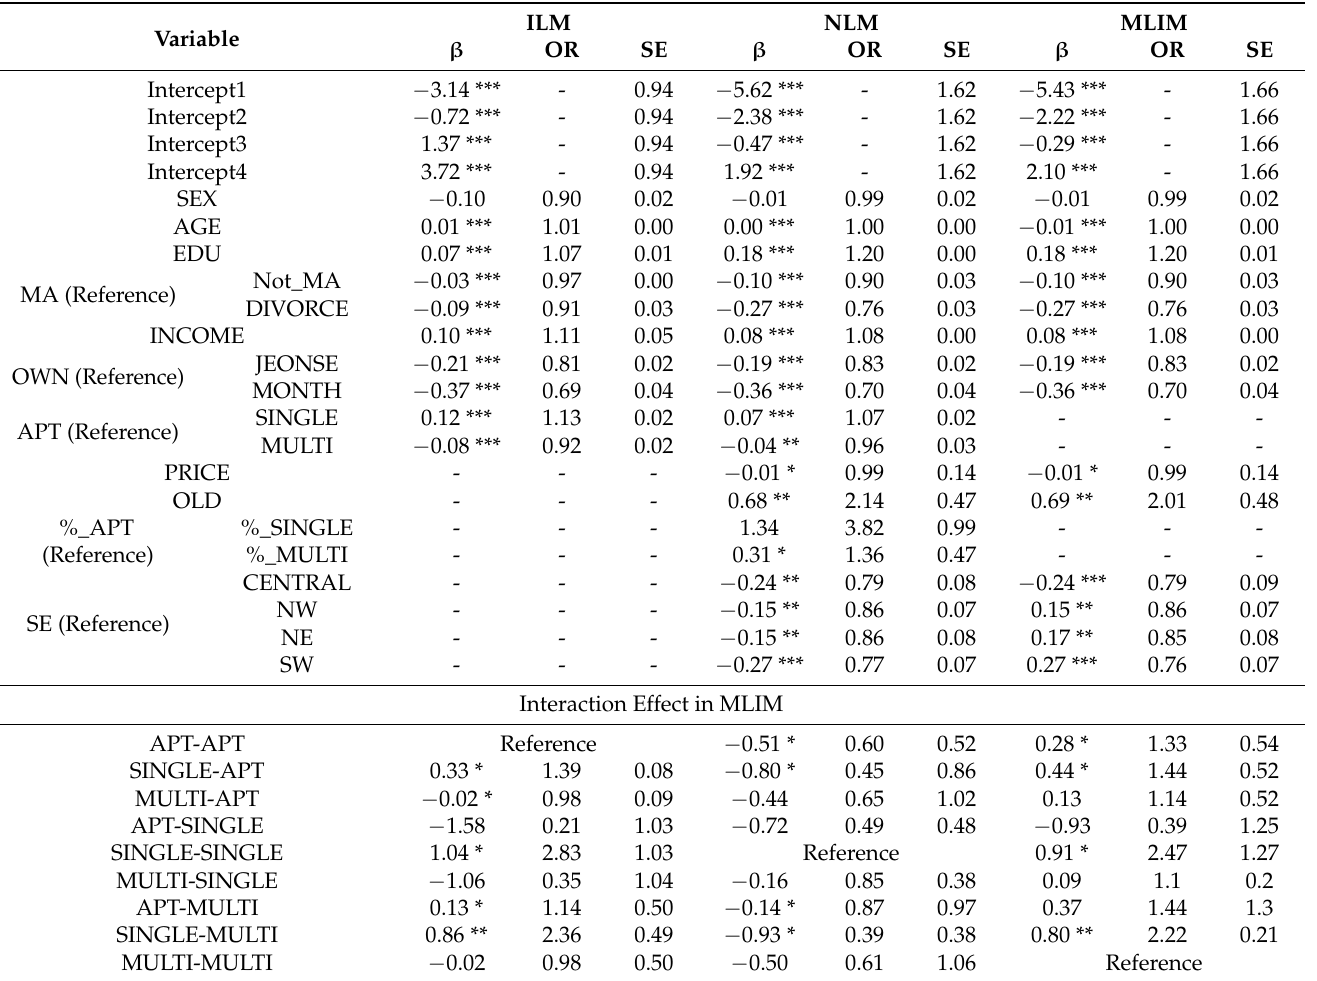
Table 5. Results of empirical